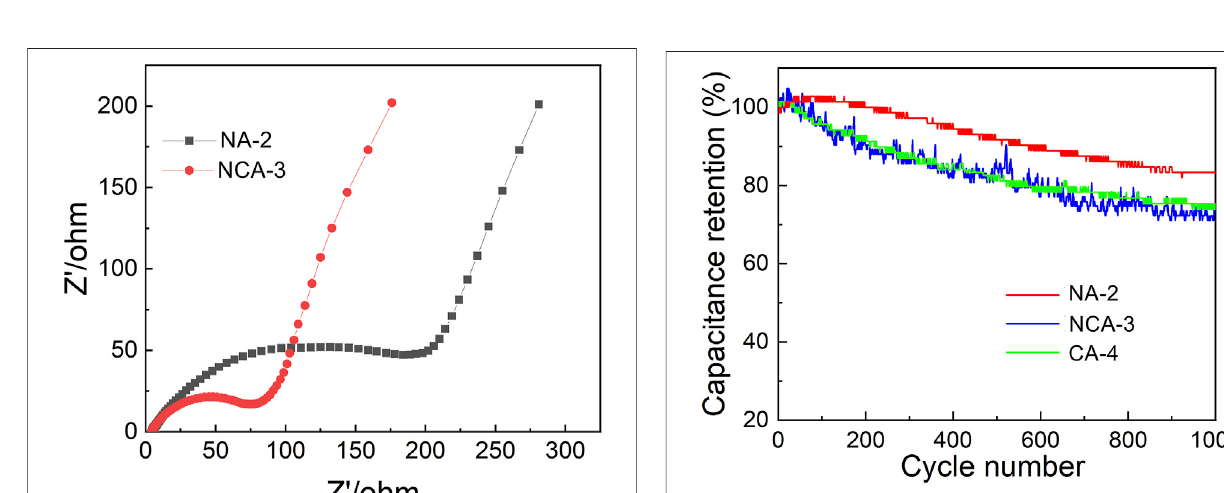
Frontiers in Energy Research |